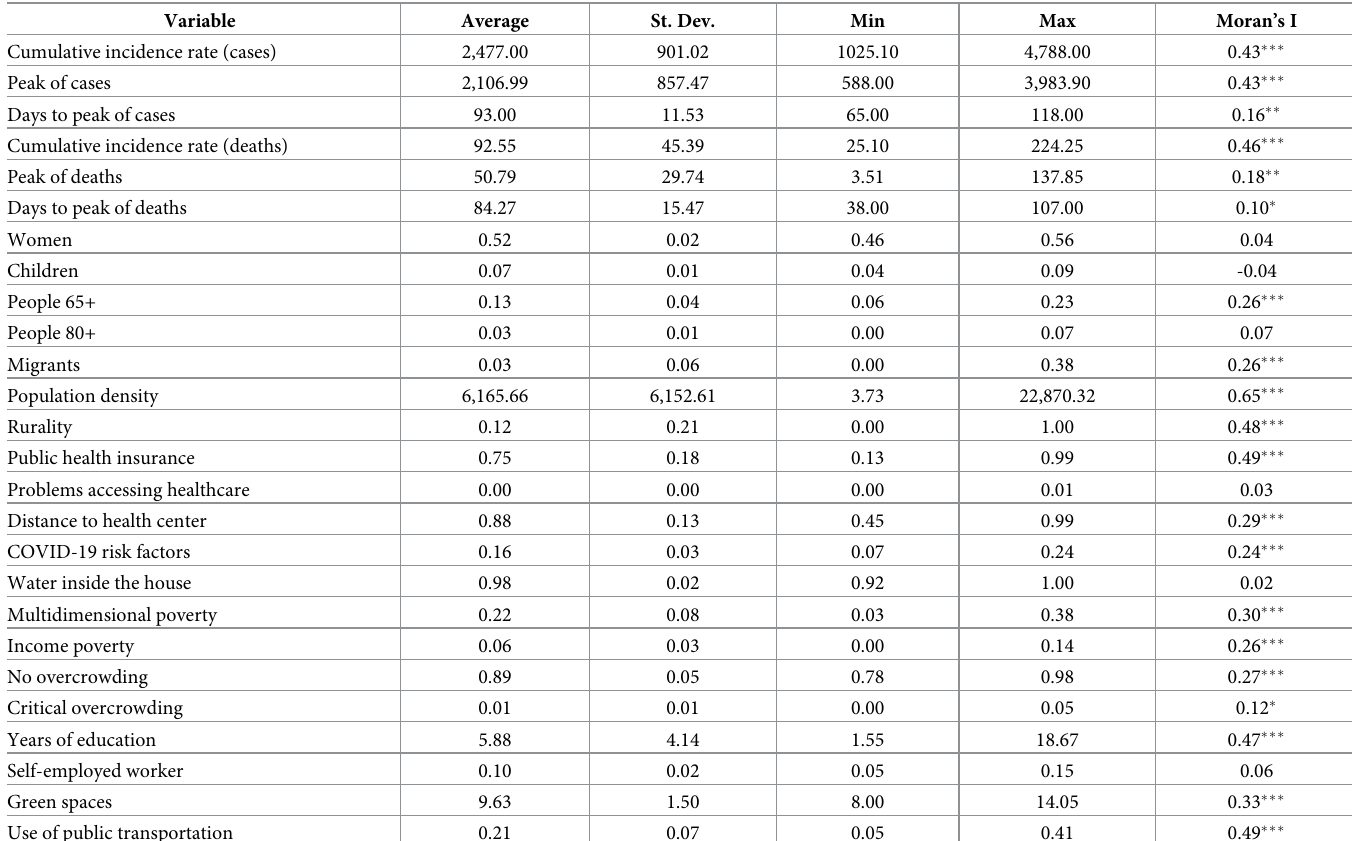
Table 3. Descriptive